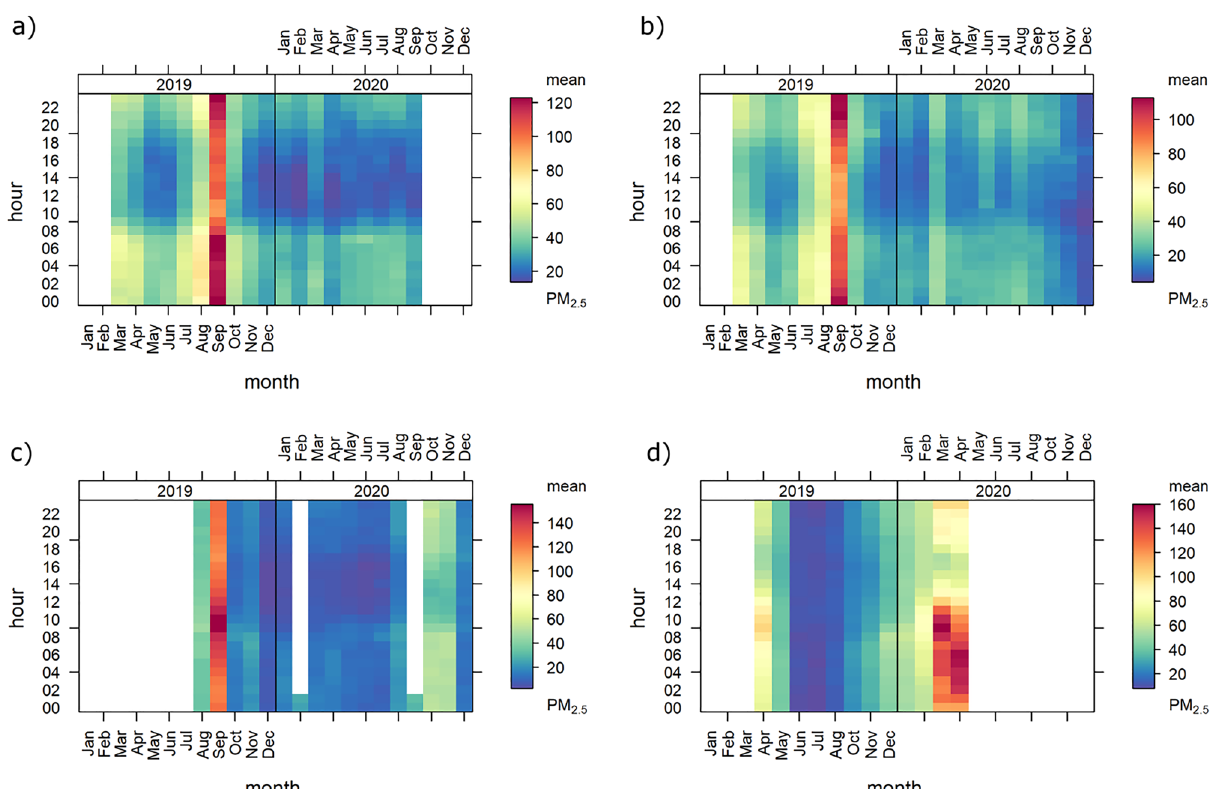
Figure 2. Monthly mean of PM 2.5 concentration at ( a ) Putrajaya, ( b ) Bukit Fraser, ( c ) Kota Samarahan and ( d ) Chiang